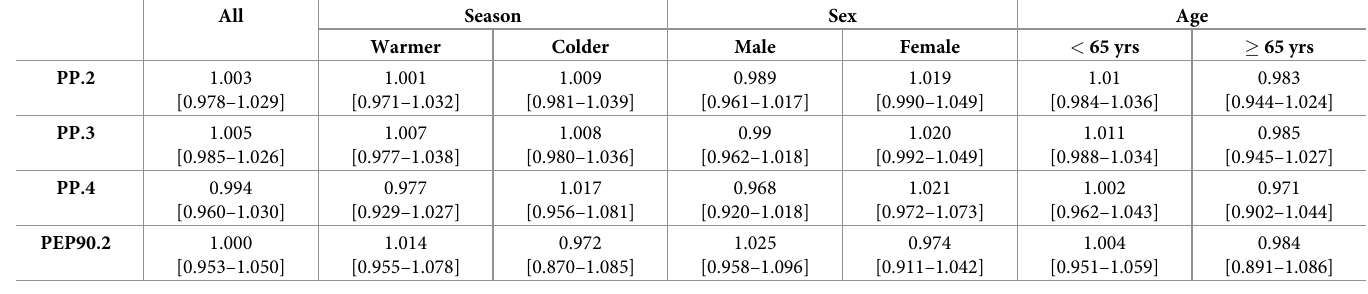
Table 3. Pooled association estimates between hospital admissions due to mental disorders and PP.2 PP.3, PP.4, and PEP90.2 events with lag 3 (Relative Risk [95% confidence interval]).